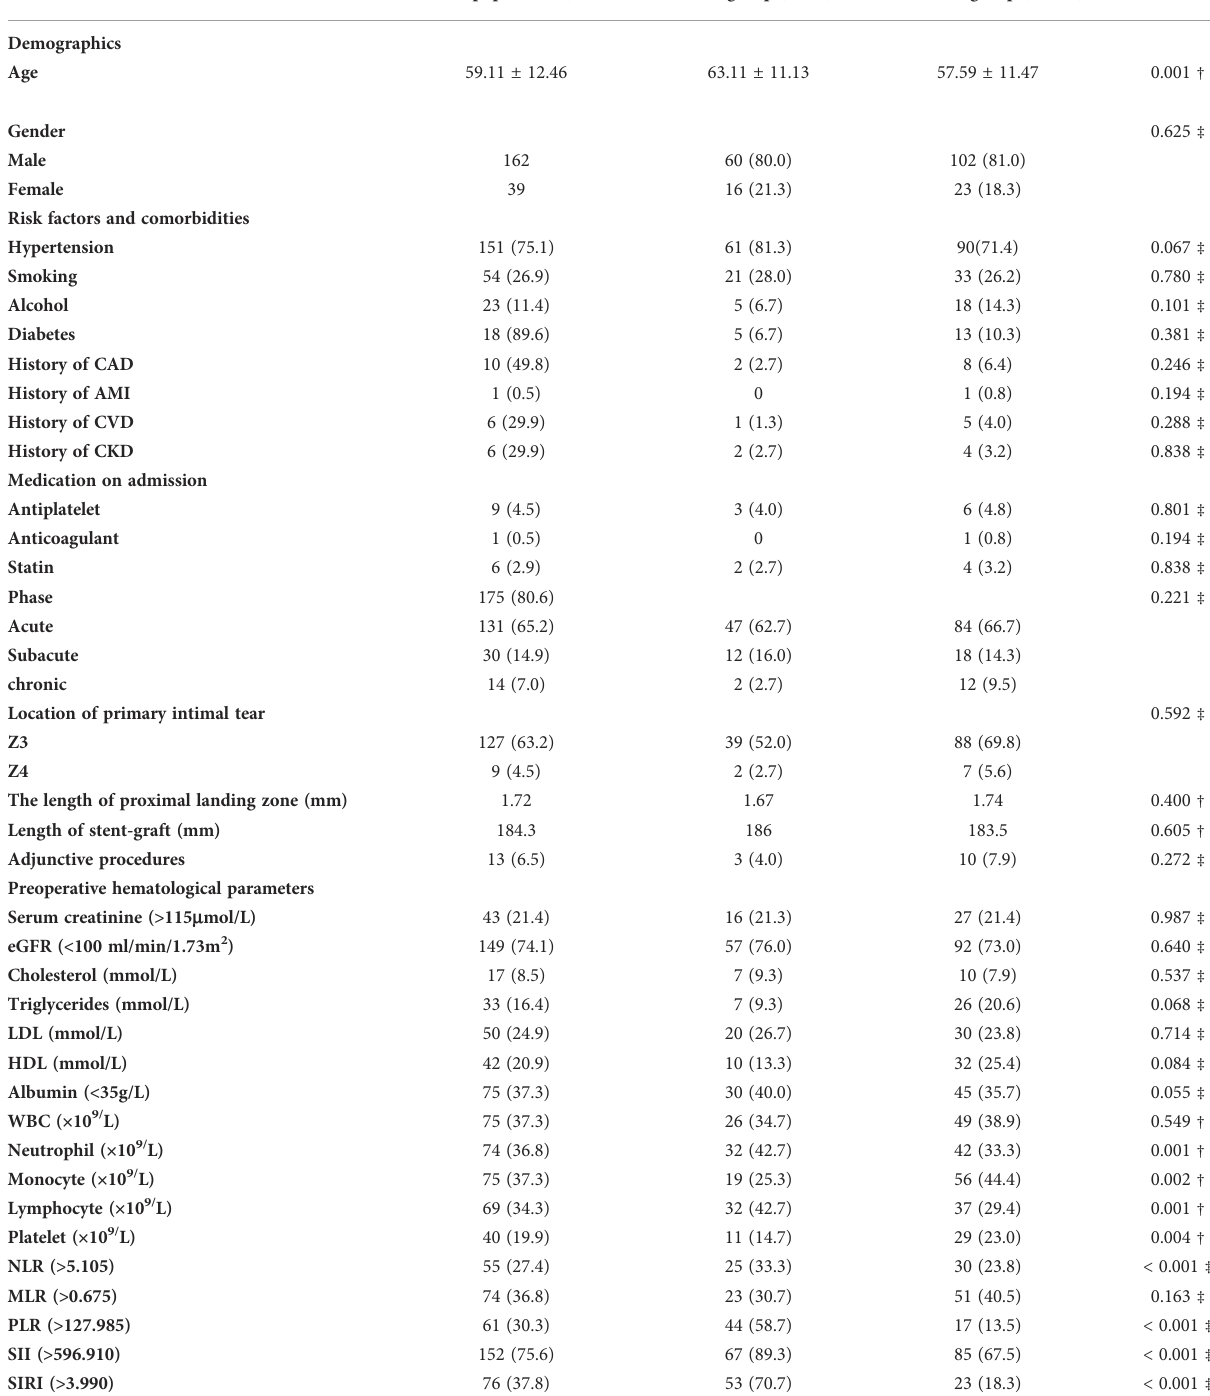
TABLE 1 Demographic and baseline